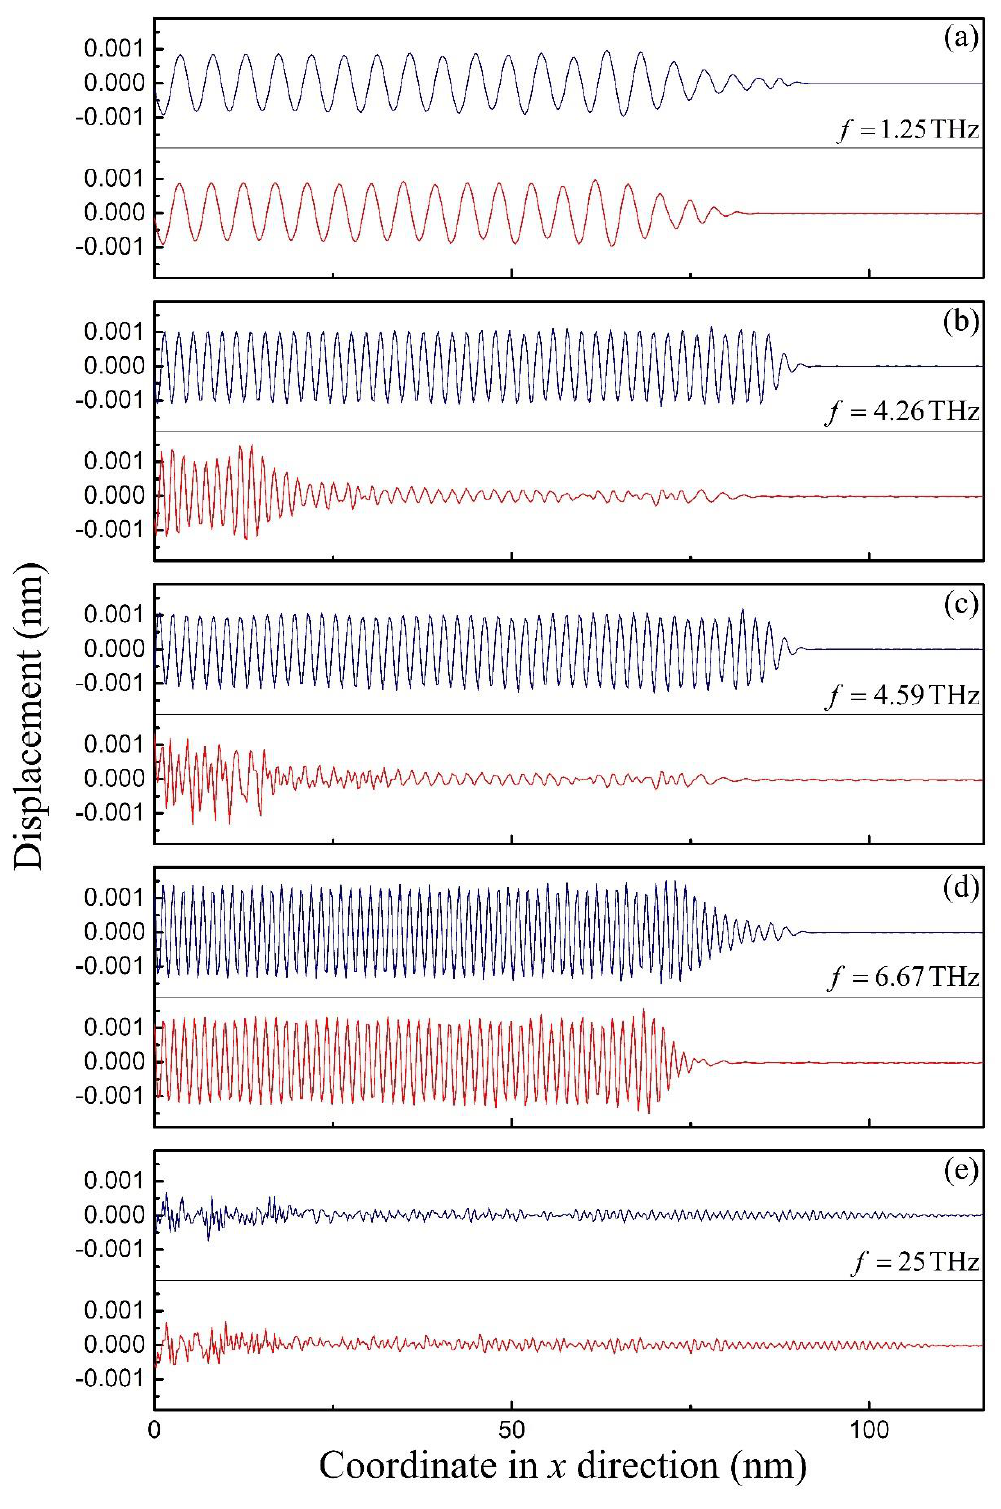
Figure 7. The propagation of waves of frequencies of ( a ) 1.25 THz, ( b ) 4.26 THz, ( c ) 4.59 THz, ( d ) 6.67 THz, and ( e ) 25 THz, respectively, in a (5, 5) SWCNT (solid line in blue) and a CCSC (solid line in red) at 80 ps, simulated by MD simulations.